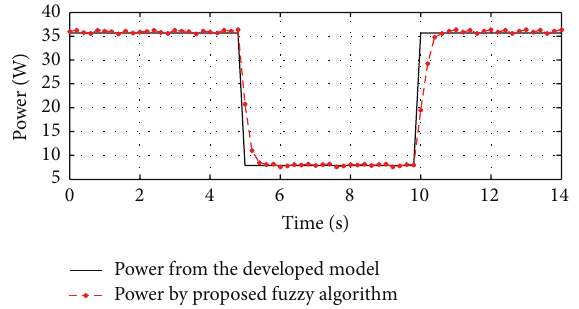
Figure 12: Tracking speed of the proposed fuzzy-based MPPT in abrupt variation of